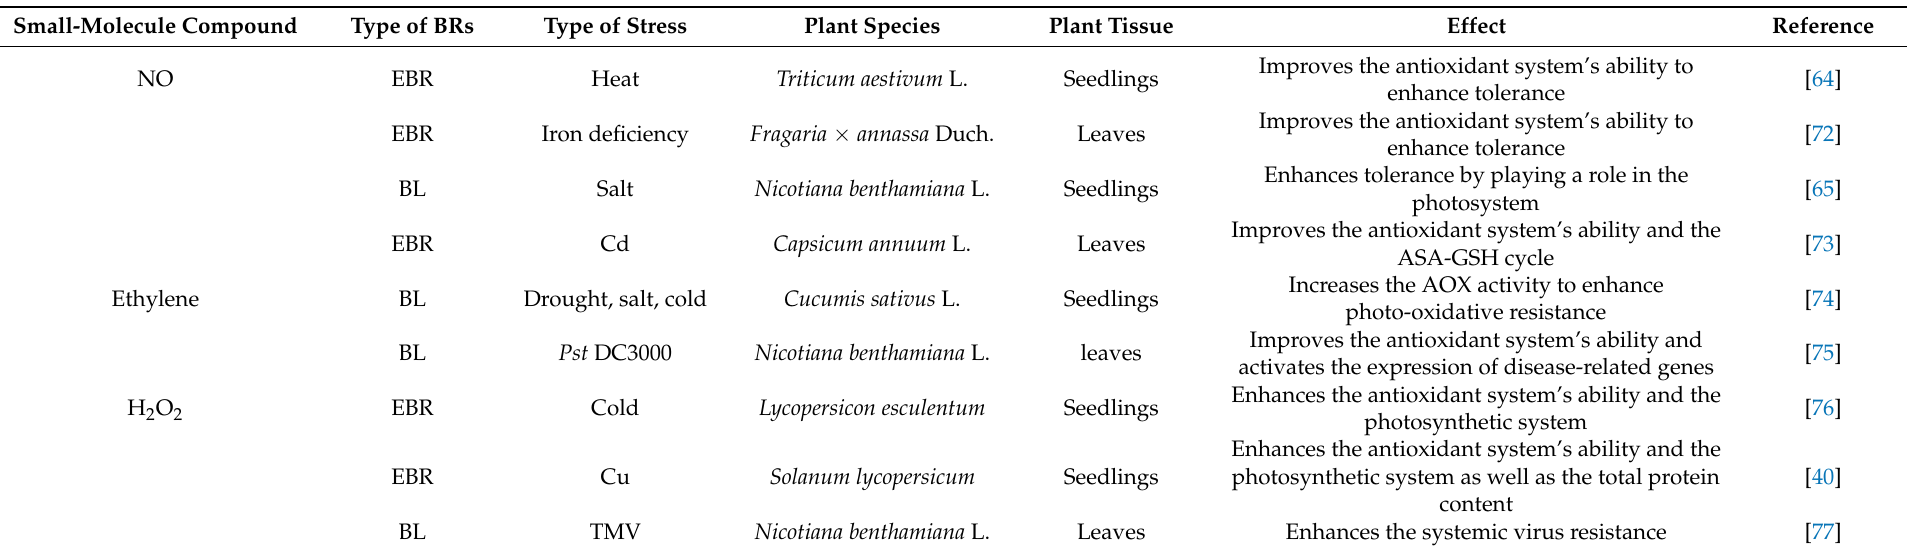
Table 1. The roles of BRs and small-molecule compounds under abiotic/biotic